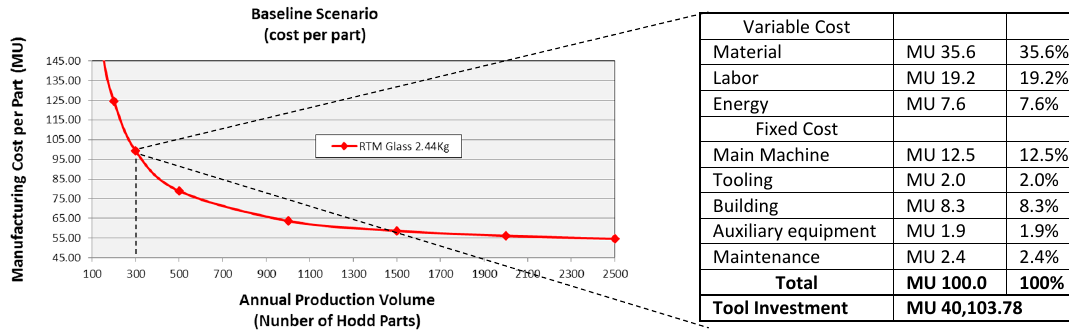
Figure 4. Baseline cost of polyester/e-glass.